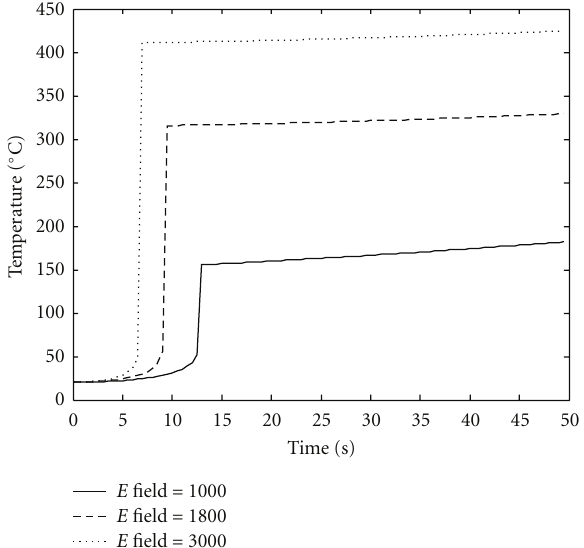
Figure 12: Theoretical influence of microwave field strength over thermal runaway in a plant stem of 16 mm diameter based on calculations using (4).